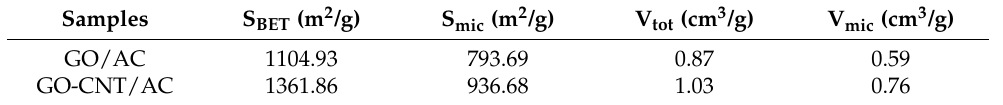
Table 2. Specific surface area and pore structure parameters of the composites.